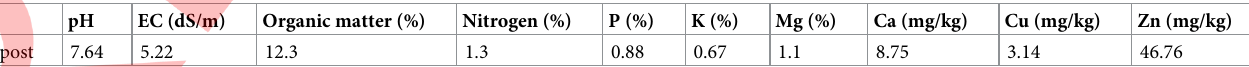
Table 2. Vermicompost